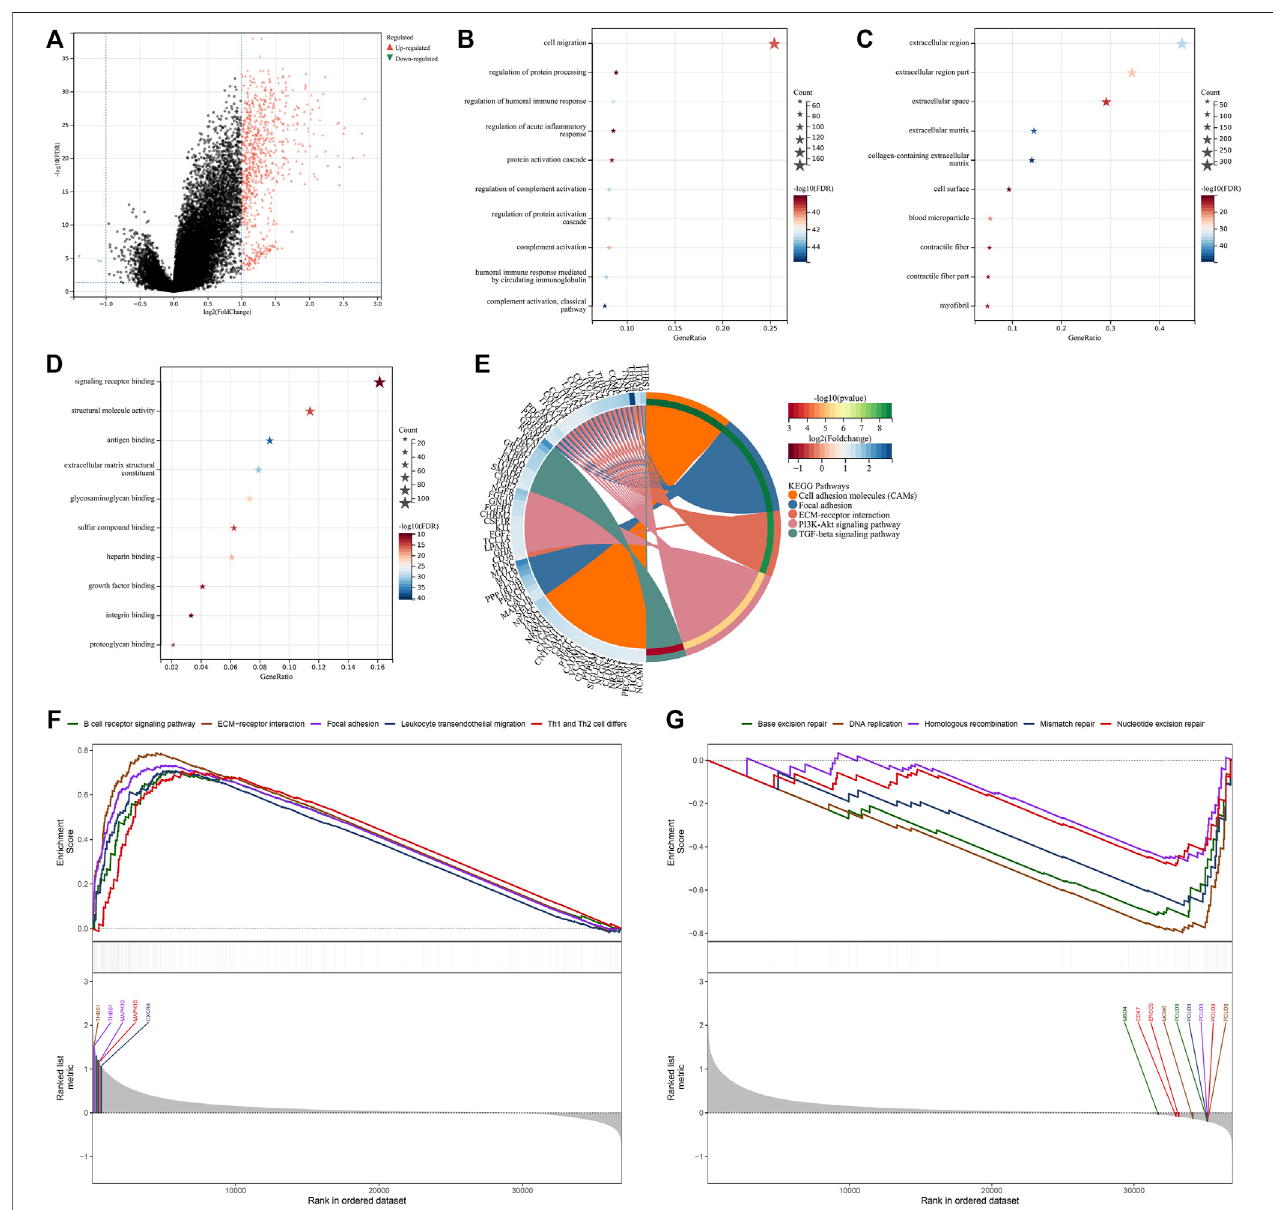
FIGURE 4 | Screening signi fi cantly altered genes between the exosome-related phenotypes and analysis of their biological implications. (A) Volcano plot for up- and downregulated genes in exosome-related phenotype A when compared with phenotype B. (B – D) Visualization of the top ten (B) biological processes, (C) cellular components,and (D) molecularfunctions,respectively. (E) Visualizationofthetop fi veKEGGpathwaysenrichedbysigni fi cantlyalteredgenes. (F) GSEAforthesignaling pathways positively correlated to signi fi cantly altered genes. (G) GSEA for the signaling pathways negatively associated with signi fi cantly altered genes.